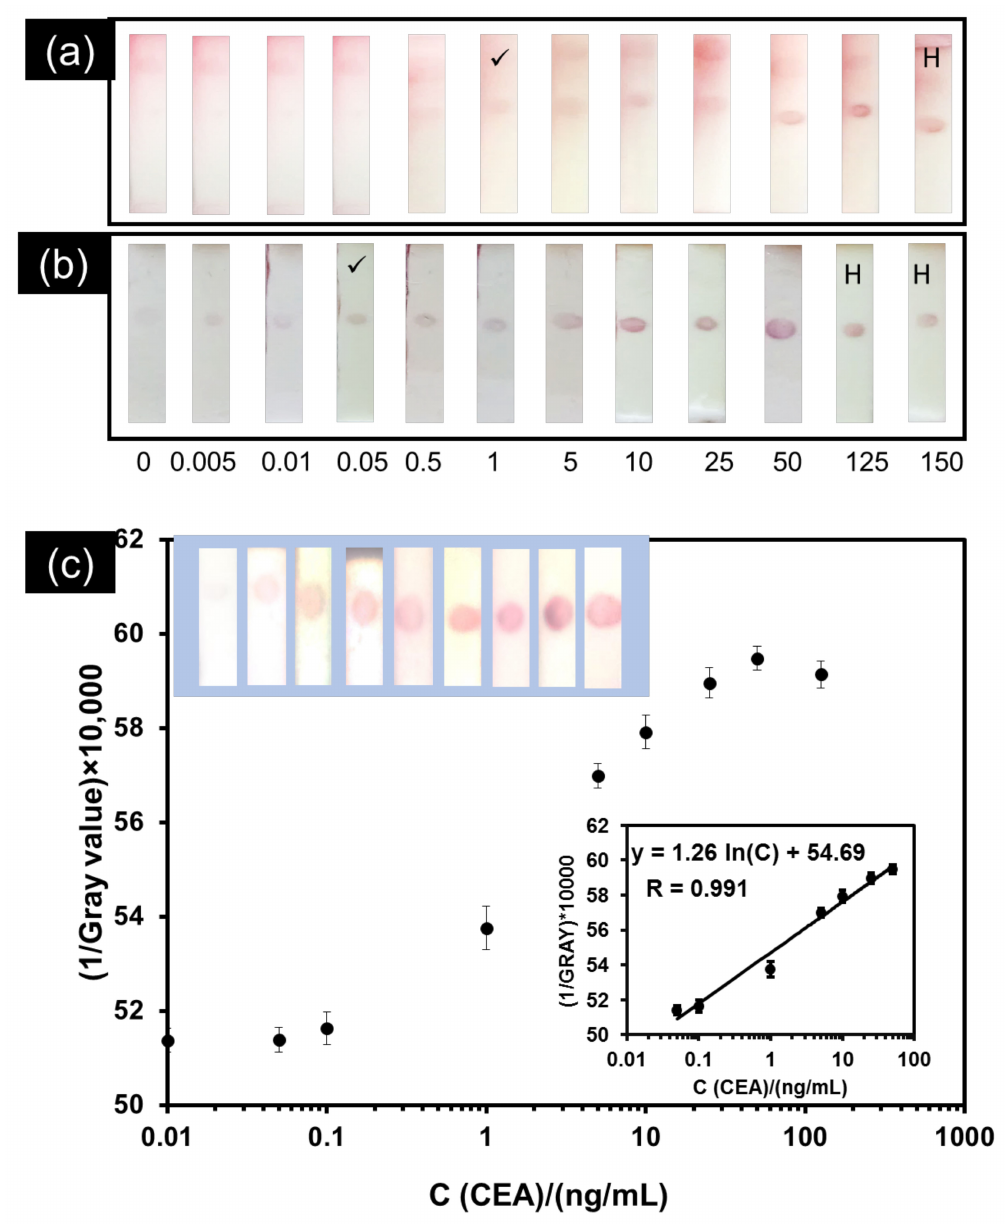
Figure 1. Images of strips taken without the imaging platform: ( a ) GNPs and ( b ) GNP@PDA as tags for different values of √ CEA in buffer solution (in ng/mL), ( shows the visual limit of detection, H represents the occurrence of the hook effect), and ( c ) (1/Gray value)* × 10,000 vs. concentration of CEA (ng/mL) in standard serum samples. Insets: calibration curve for analysis of CEA, and images of strips taken with the imaging